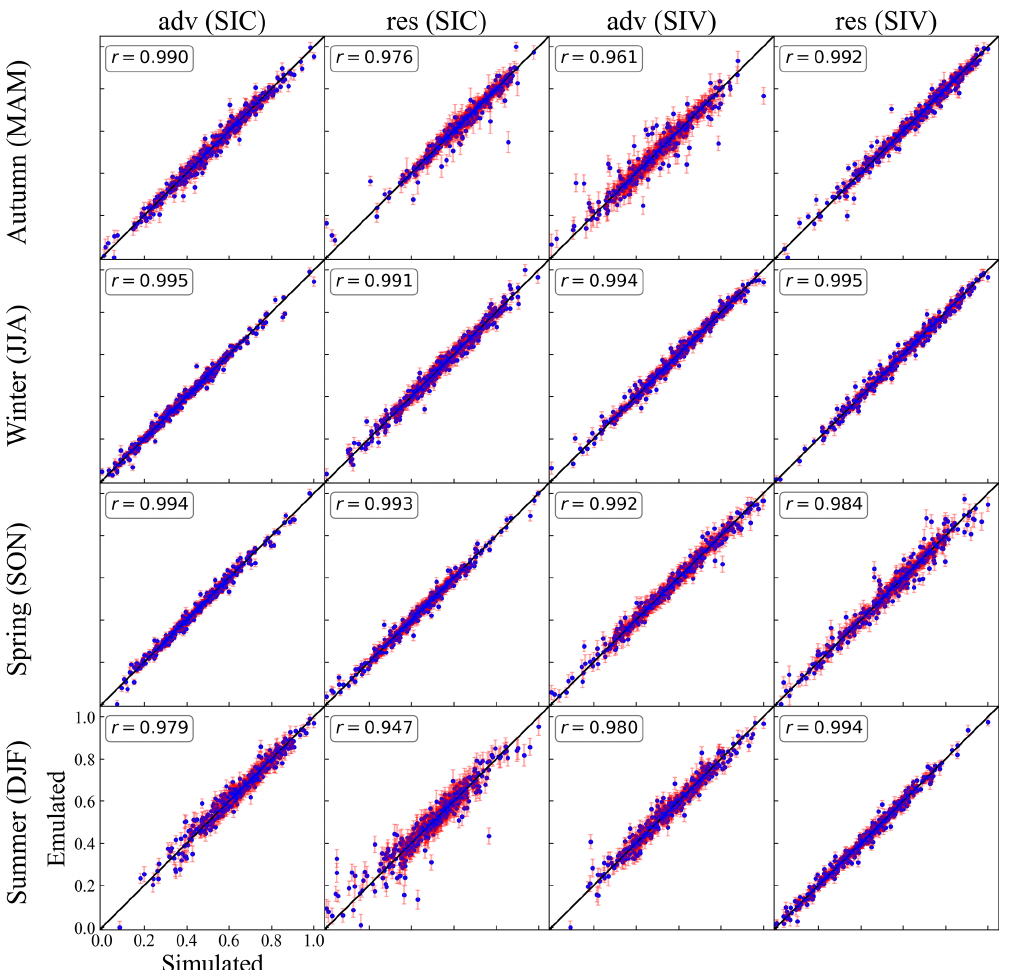
Figure B4. Validation results of the best Gaussian process (GP) emulators for each of the four metrics (area integrals of adv and res components in SIC and SIV budgets) selected by the 10-fold cross-validation. Each subplot consists of 449 error bars and a 1 : 1 line, and Pearson correlation coefficients are also listed. Each metric has been normalized (scaled to 0, 1 using the difference between the maximum and minimum values of the simulation) for better